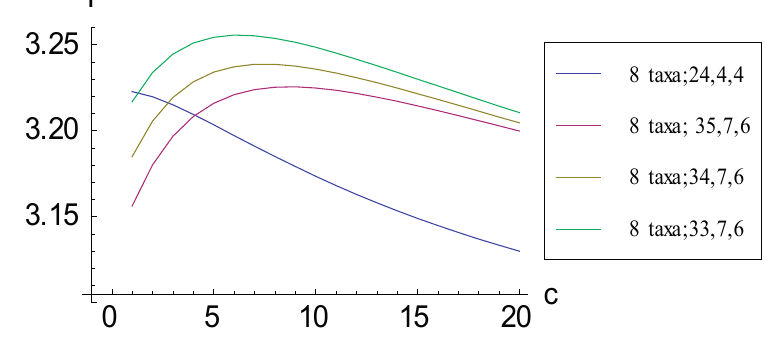
Figure 8. Plots relating information measure I and added character vectors c containing two 1s ( i . e ., synapomorphic character states grouping two taxa) for four consistent basal matrices for eight taxa. Three plots descend qualitatively in a similar pattern to those followed when character vectors encoding autapomorphic character states are added (Figures 5–7). For the symmetric representation (8 taxa; 24, 4, 4), I changes markedly.